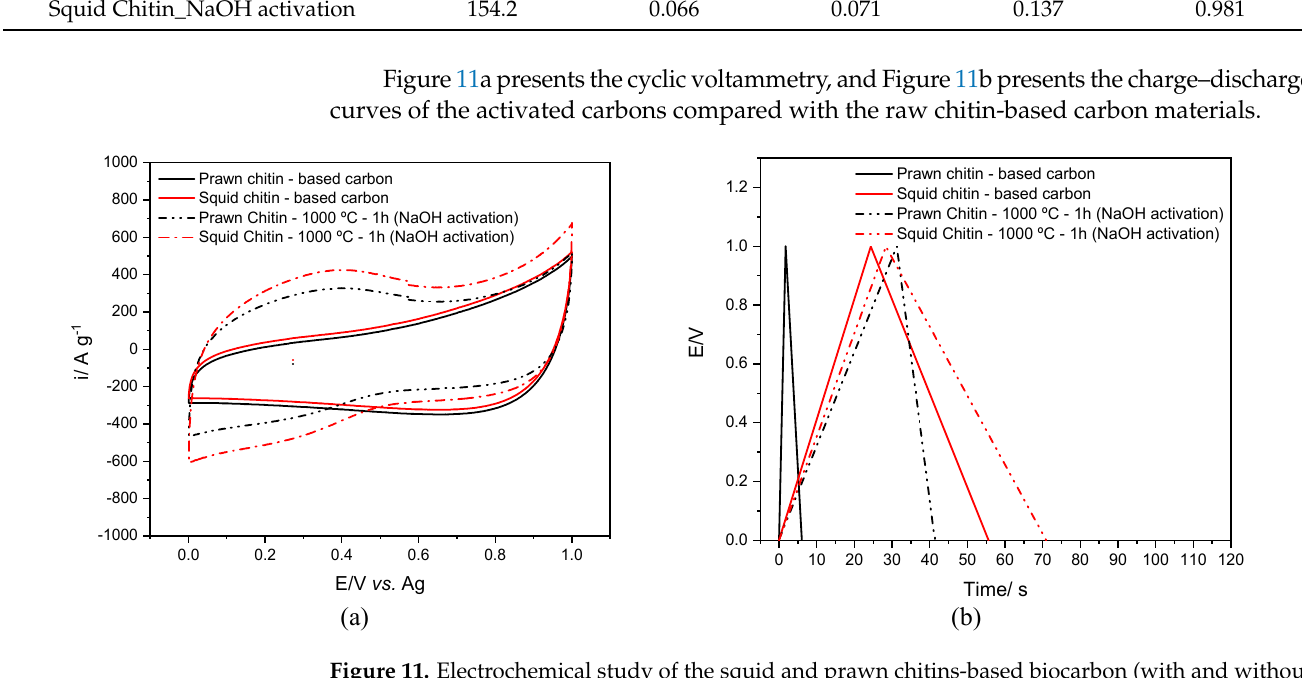
Figure 11. Electrochemical study of the squid and prawn chitins-based biocarbon (with and without NaOH activation) in DES electrolyte (ethaline), ( a ) cyclic voltammetry at 50 mV s − 1 , and ( b ) galvanostatic charge–discharge curves recorded with current density 1 A g − 1 at 30 °C.